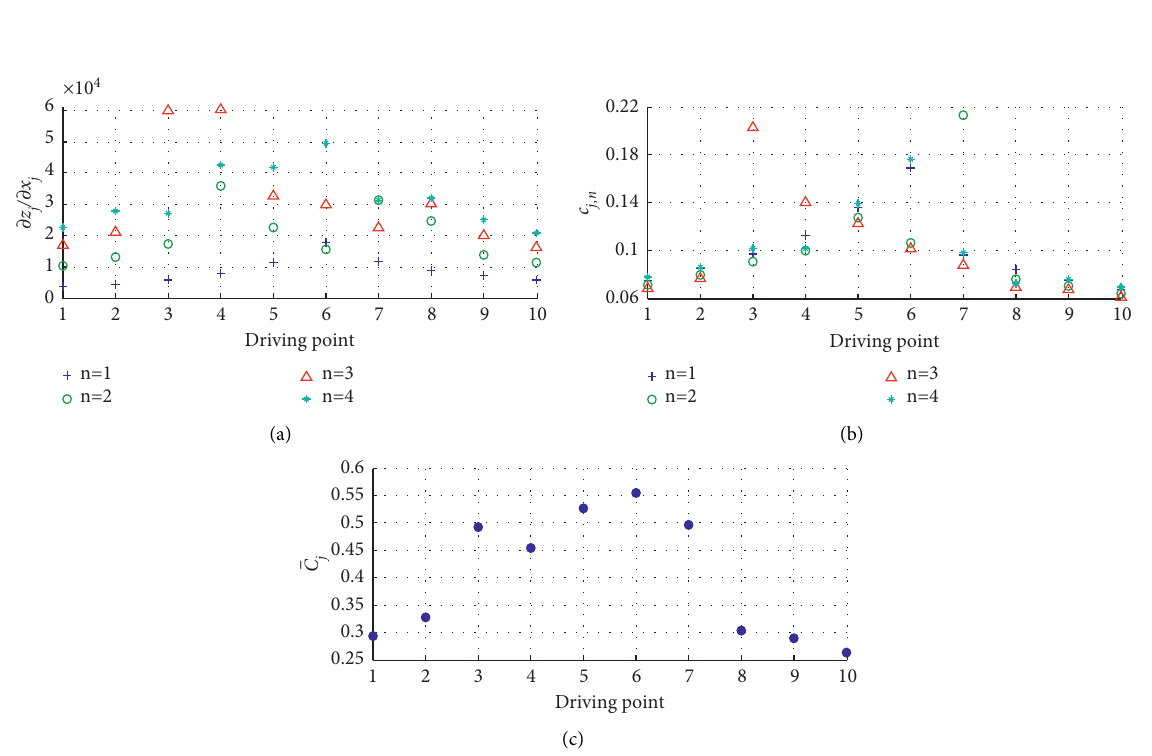
Figure 3: (a) The sensitivity coefficients z z coefficients c j,n ( j � 1 , 2 , ... , N P ; n � 1 , 2 , .. . ,N m ) . (c) The overall sensitivity C j of driving point j ( j � 1 , 2 ,..., N P )